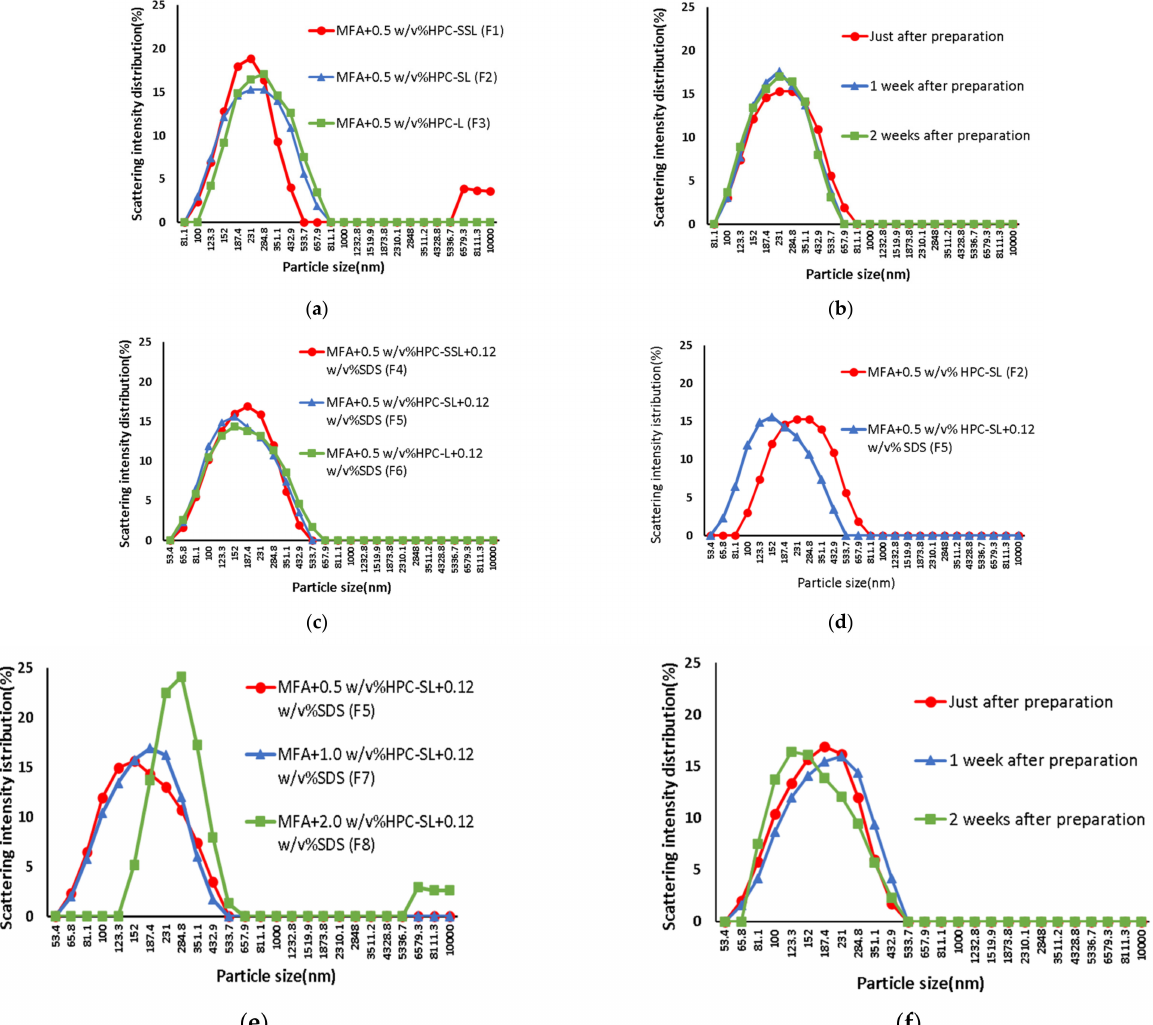
Figure 1. Size distribution of MFA particles in each sample: ( a ) F1-F3 immediately after preparation, ( b ) F2 immediately after preparation to 2 weeks after preparation, ( c ) F4–F6 immediately after preparation, ( d ) F2 and F5 immediately after preparation, ( e ) F5, F7, and F8 immediately after preparation, ( f ) F7 immediately after preparation to 2 weeks after